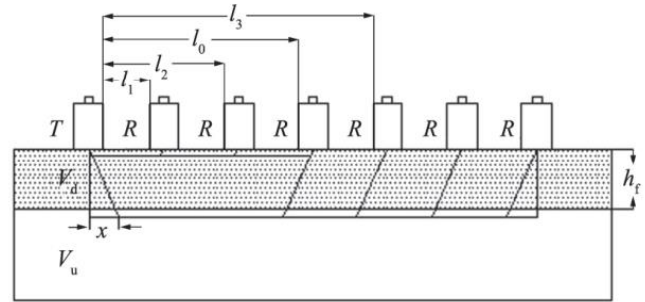
Figure 2. Schematic illustration of the horizontal survey